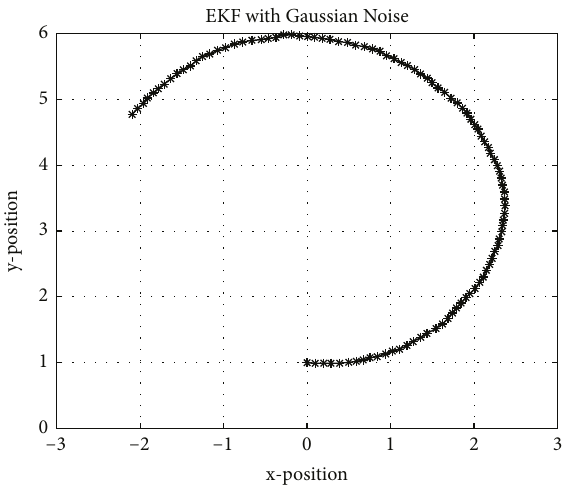
Figure 1: State of the WMR with the EKF (one landmark and Gaussian noise).